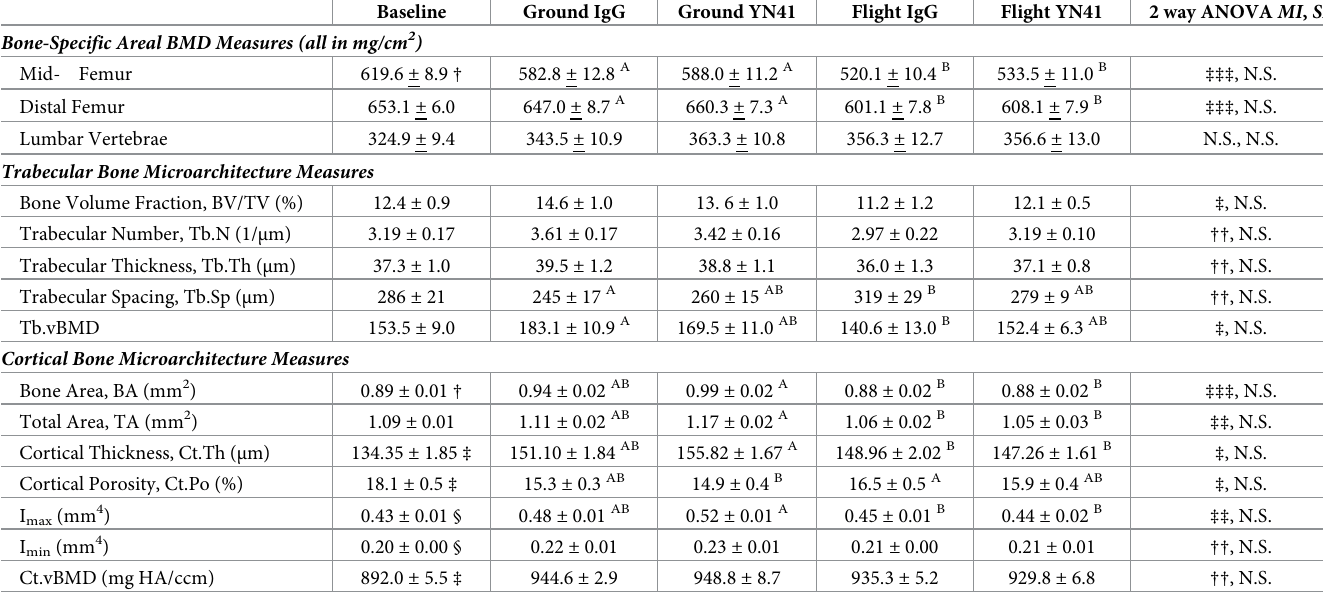
Table 2. Age and microgravity, but not myostatin inhibition, influence vBMD in the femur but not the vertebrae. Age and microgravity, but not myostatin inhibition, also influence both trabecular and cortical bone microarchitecture at the distal femur. Baseline Ground IgG Ground YN41 Flight IgG Flight YN41 2 way ANOVA MI ,